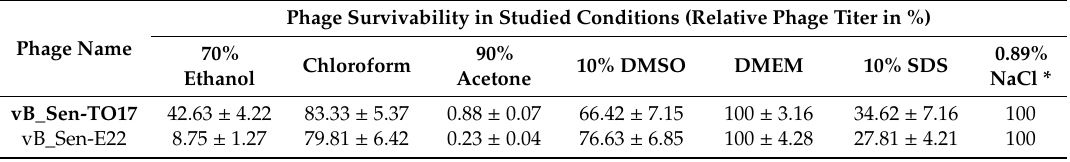
Table 4. Survivability of phages vB_Sen-TO17 and vB_Sen-E22 at di ff erent solvents, media, and bu ff ers.